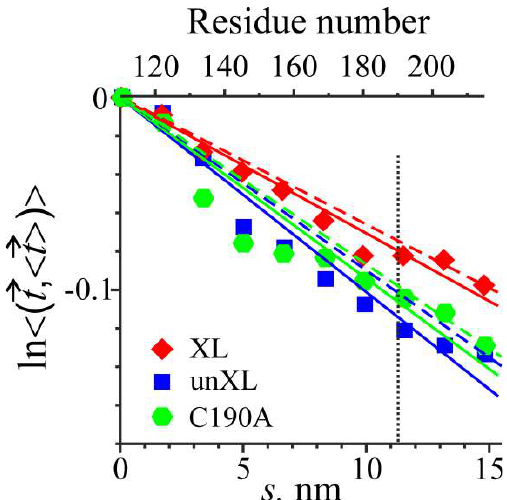
Figure 2. Flexibility plots used for estimation of persistence length of the middle part of Tpm segments MD trajectories at 27 °C. Logarithm of the time-averaged scalar product of the unit tangent vector 𝑡⃗ and the time-averaged unit tangent vector (cid:3451)𝑡⃗(cid:3455) is plotted against the distance along the axis of the Tpm coiled-coil. Blue squares, red diamonds and green hexagons correspond to uncross-linked, cross-linked and C190A Tpm, respectively. The solid lines show the slope of least squares fit; the dashed lines are the secants connecting the first and the last points; and the dotted vertical line shows the position of residue 190. The bending stiffness is proportional to persistence length and reciprocal to the slopes of the lines. S.E.M. bars for each data point are within data symbols. See text and Table 1 for details of the flexibility analysis.